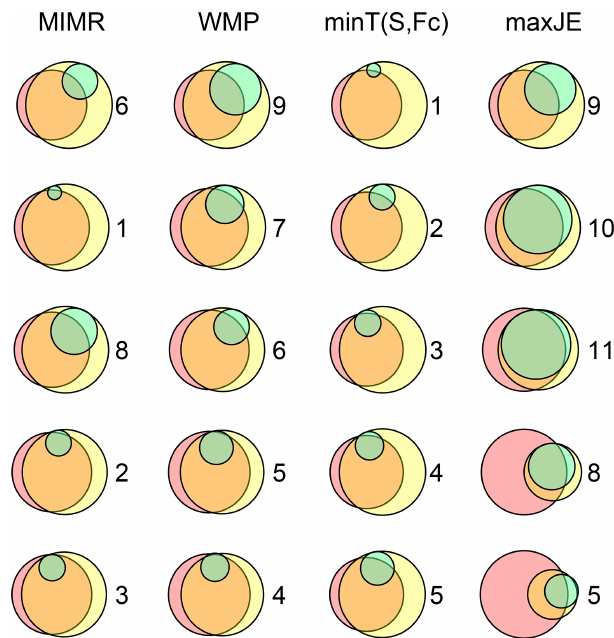
Figure 6. Approximately proportional Venn diagrams showing the evolution of information measures when progressively (going down the rows) selecting stations (selected station for each step indi- cated by the numbers) using four different methods (in the different columns). The interpretation of the color-coded areas representing the information measures is the same as in Fig. 1. All methods se- lect station 12 as the initial station (entropy given by pink circle in row 1). As can be seen from the diagram on the bottom right, the method maximizing joint entropy leaves almost no information un- measured (yellow part) with just six stations, while the other meth- ods still miss capturing this information. Exact numbers behind the Venn diagram can be found with the code available with this